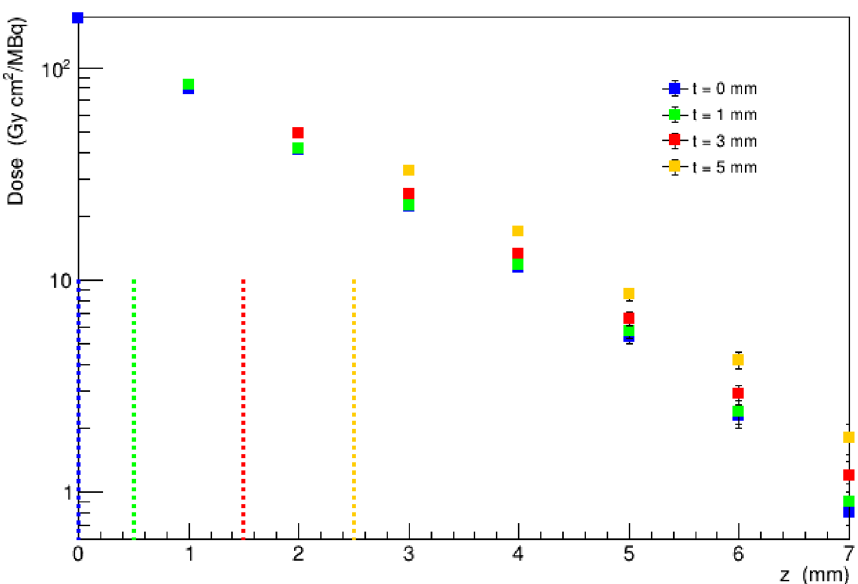
Figure 3. Dose per activity on unit area values in the water bulk material, on planes located at different distances z from the tumour bed, for different thicknesses t of the BAT-90 layer (colour code). The vertical dashed lines correspond to the upper surface position of the BAT-90 layer (corresponding to t/2, since the layer is centered in the coordinate system). Dose values are reported only for the bulk material outside BAT-90 (for z >